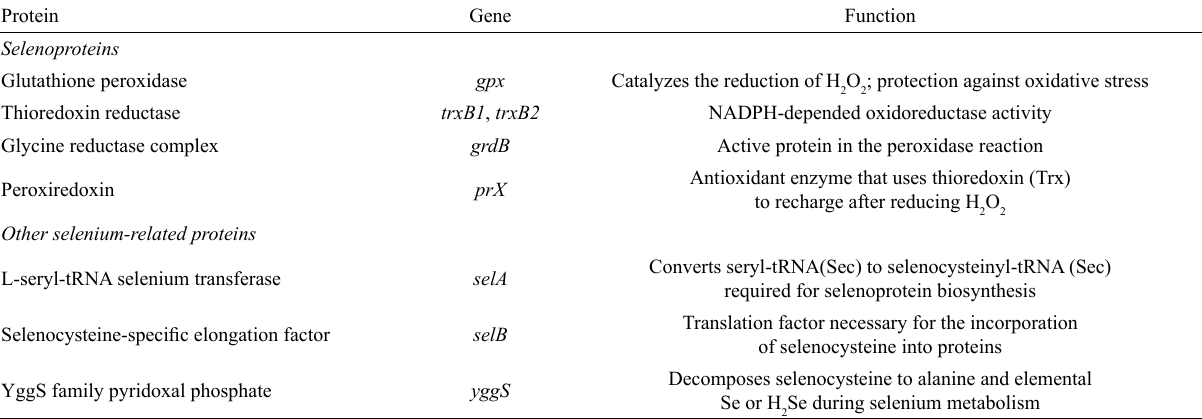
Table 3 – Selenoprotein related genes predicted in E. durans LAB18S genome.